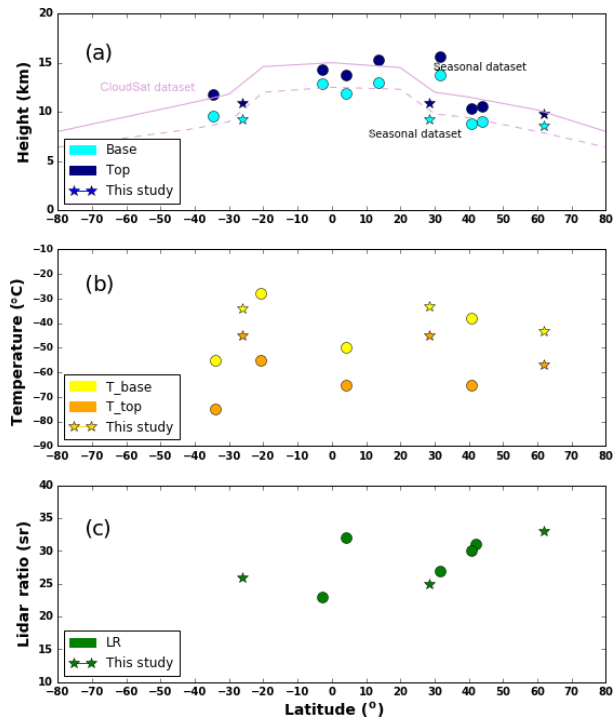
Figure 7. Latitudinal dependence of cirrus properties. In (a) , which shows latitudinal dependence on cirrus base and top height, circles denote estimations from ground-based lidar from the literature (see Table 5 for references), stars denote estimations from this study, and lines correspond to CloudSat estimations according to Sassen et al. (2008). Panel (b) shows latitudinal dependence on temperature, where circles denote estimations from ground-based lidar from the literature (see Table 5 for references) and stars denote estimations from this study. Panel (c) shows latitudinal dependence on lidar ra- tio values, where circles denote estimations from ground-based li- dar from the literature (see Table 5 for references) and stars denote estimations from this